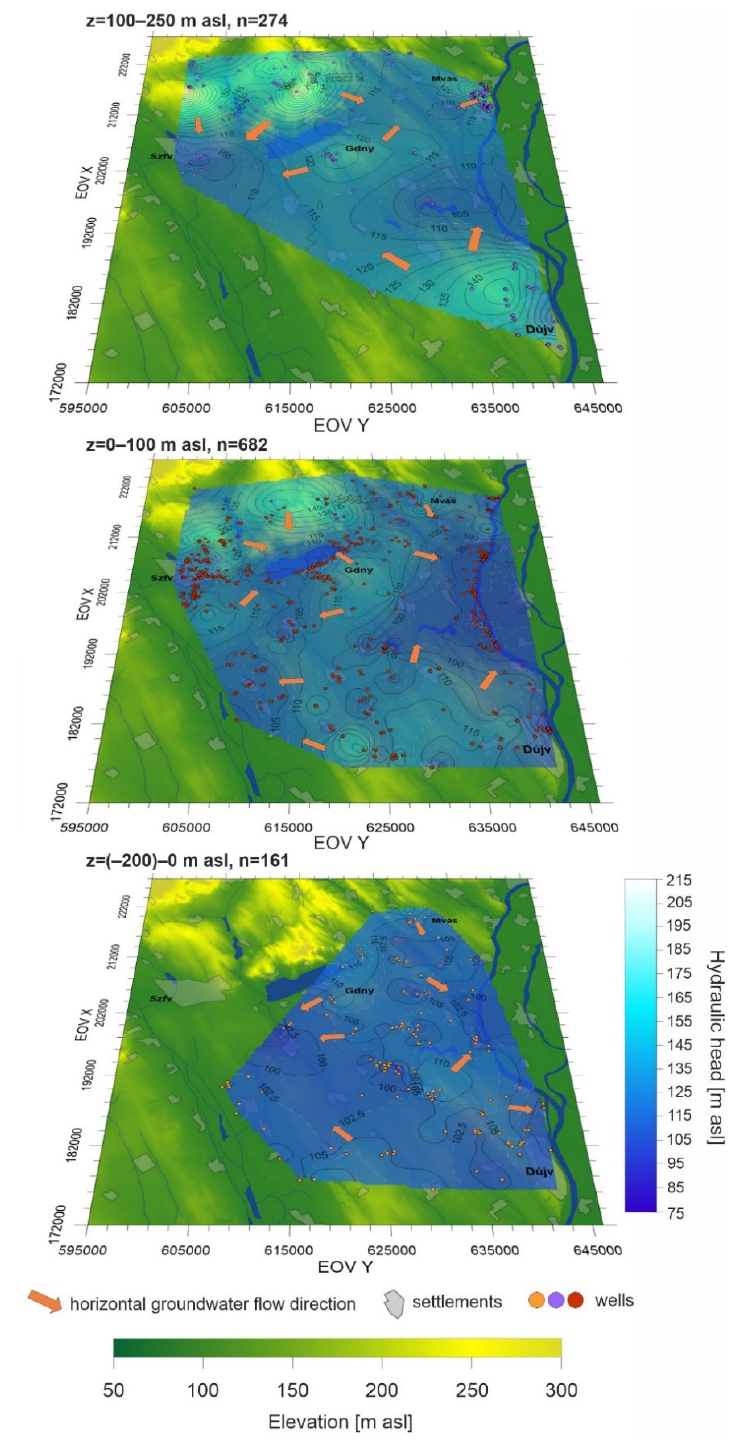
Figure 4. Tomographic potential maps constructed in accordance with data availability in depth. Main settlements: Szfv—Székesfehérvár, Gdny—Gárdony, Mvás—Martonvásárhely, Dújv—Du-